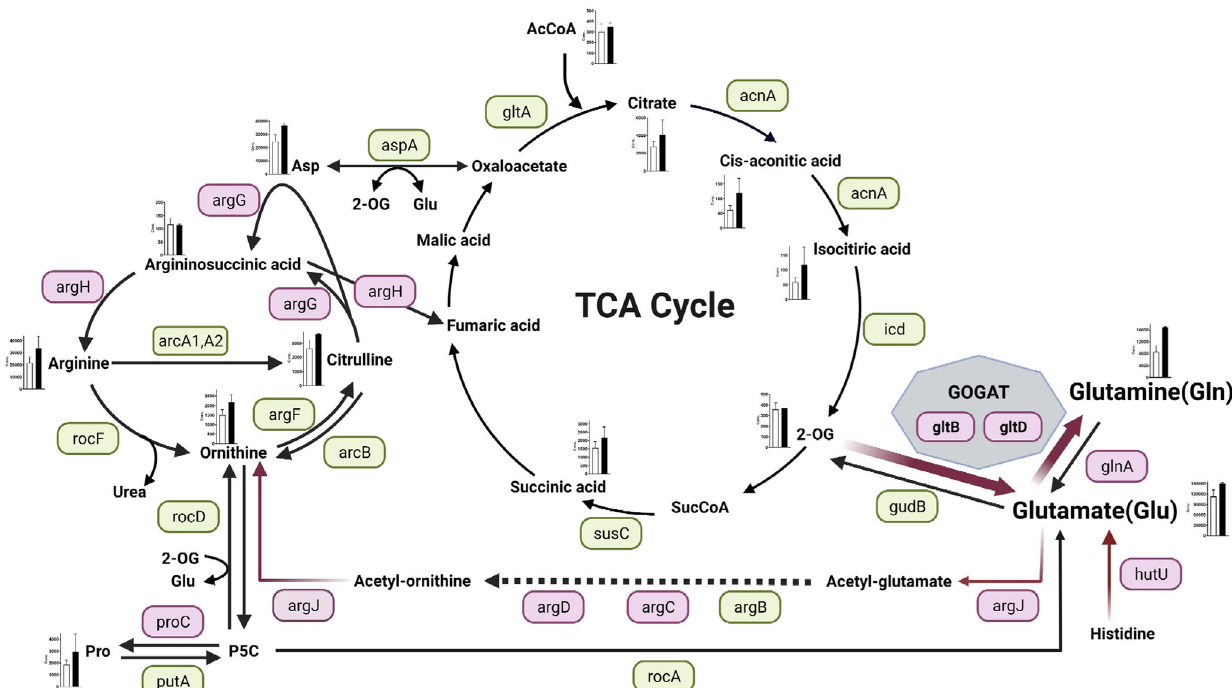
Fig. 9 Metabolic changes induced by gltS::Tn in TSB. Red indicates that the expression of the gene was higher than that of the parent strain by RT- qPCR at any of the observation times from 0 to 48 h, and green indicates that there was no signi fi cant difference between the strains. However, even if there is a signi fi cant difference, the expression ratios of both strains that are less than 1-fold of the reference (JE2 time 0) are omitted and shown in green. For hutU, RNAseq data showed that expression was signi fi cantly ( p < 0.05) higher than 2-fold in the gltS::Tn strain, hence it is additionally shown in pink. Absolute values of the concentration of each metabolite in the cells of 48-h bio fi lms are shown in the bar graph. White indicates the parent strain and black indicates gltS::Tn